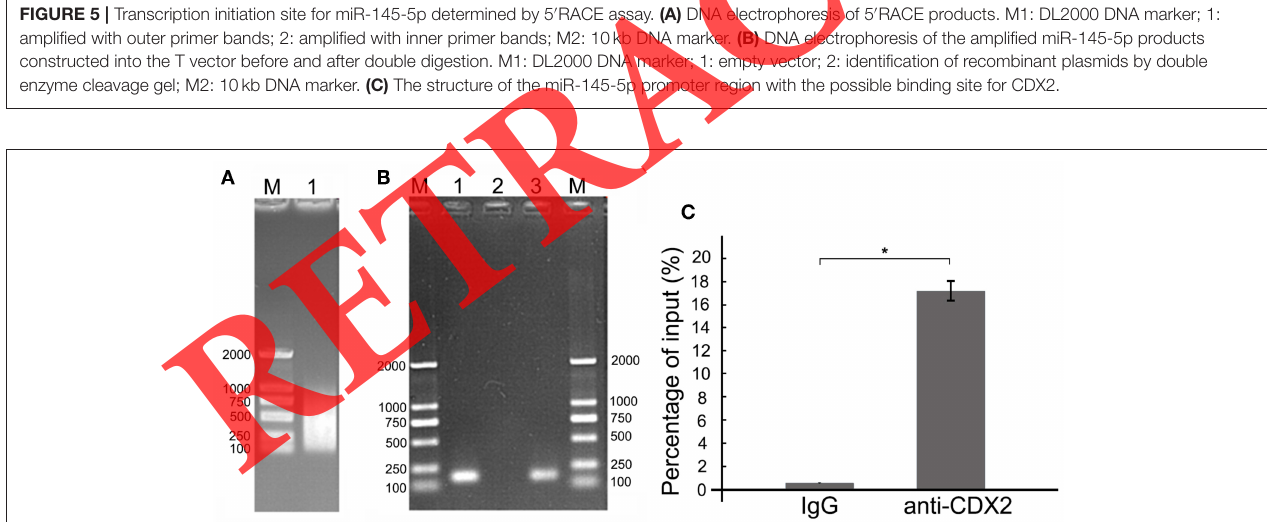
FIGURE 5 | Transcription initiation site for miR-145-5p determined by 5 ′ RACE assay. (A) DNA electrophoresis of 5 ′ RACE products. M1: DL2000 DNA marker; 1: amplified with outer primer bands; 2: amplified with inner primer bands; M2: 10kb DNA marker. (B) DNA electrophoresis of the amplified miR-145-5p products constructed into the T vector before and after double digestion. M1: DL2000 DNA marker; 1: empty vector; 2: identification of recombinant plasmids by double enzyme cleavage gel; M2: 10kb DNA marker. (C) The structure of the miR-145-5p promoter region with the possible binding site for CDX2.